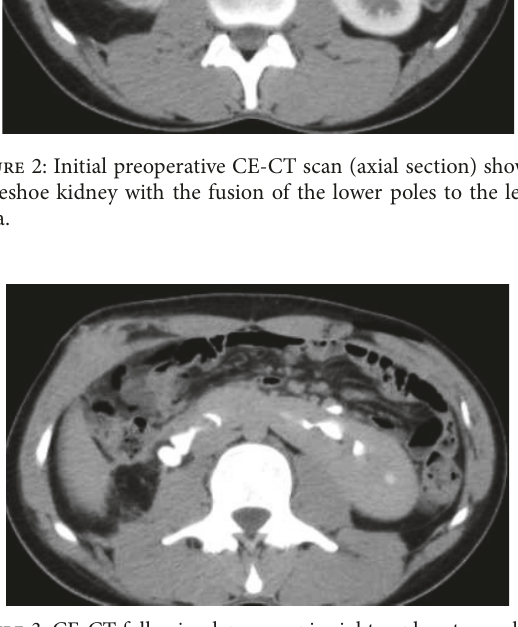
Figure 3: CE-CT following laparoscopic right nephrectomy show- ing leakage of contrast from the residual stump of the right lower pole.